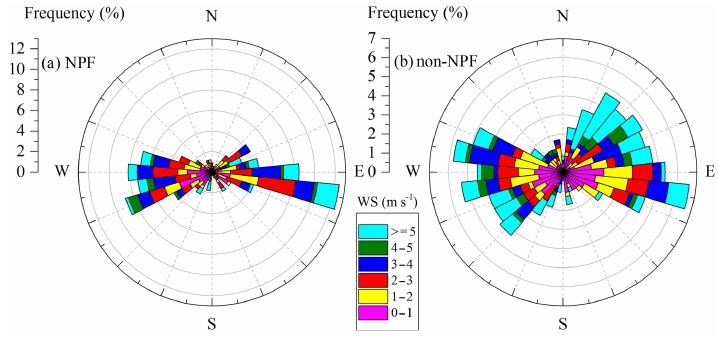
Figure 4. Wind rose plots of all NPF days (a) and non-NPF days (b) and wind speed and wind direction between 06:00 and 11:00LT are included. The length of each spoke on the circle represents the probability of wind coming from a particular direction at a certain range of wind